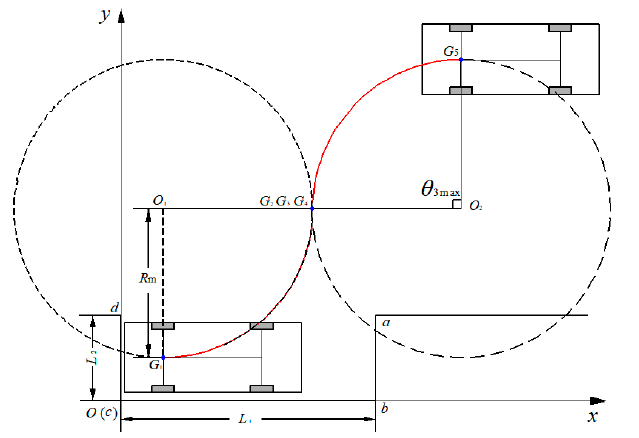
Figure 12. Extreme position of parallel parking showing θ 3max.